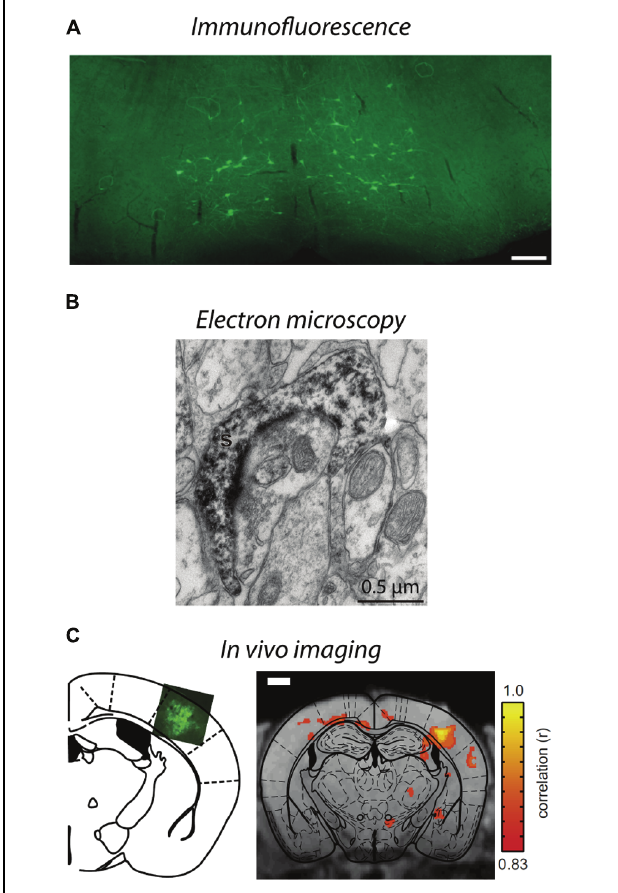
FIGURE 4 | Visualization of lentivirus transduced neurons in post-mortem tissue and in situ imaging. (A) Injection of B19/VSVg-LV-GFP into the lumbar spinal cord resulted in prominent transduction of neurons in the brainstem. Scale bar = 50 μ m. Reproduced with permission from Schoderboeck et al. (2015). (B) An electron micrograph of a lentivirus transduced spine in the monkey striatum expressing eYFP. eYFP-tagged neuronal elements were made electron dense by using immunoperoxidase labeling with DAB as the chromogen, prior to general processing for electron microscopy. Reproduced with permission from Galvan et al. (2012). (C) In situ BOLD signals from opto-functional MRI in mice (Desai et al., 2011). Channelrhodopsin-GFP expression following injection of LV-FCK-ChR2- GFP into the somatosensory cortex (left). Voxels with significant increases in BOLD signal (color scale) are shown 1 mm posterior to bregma (right). Reproduced with permission from Desai et al.